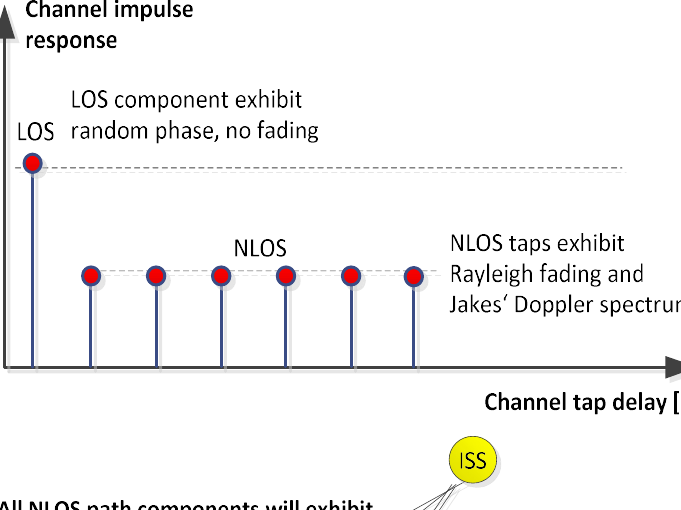
Figure 14. ICARUS Multipath Propagation Scenario.